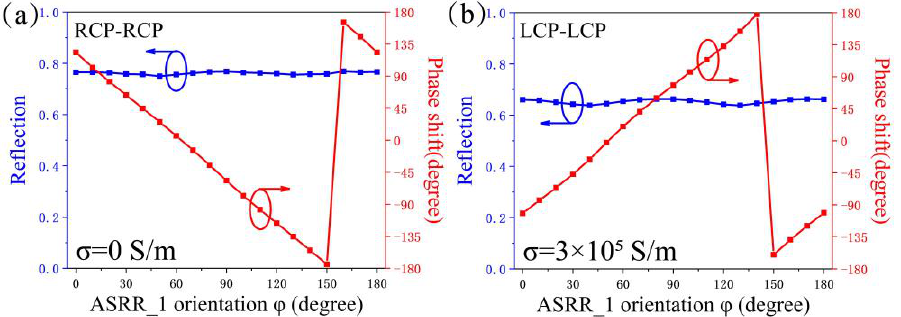
Figure 5. The reflection amplitude and phase changes of ASRR_1 with conductivities of ( a ) 0 S/m and ( b ) 3 × 10 5 S/m with different orientations θ around the z -axis.